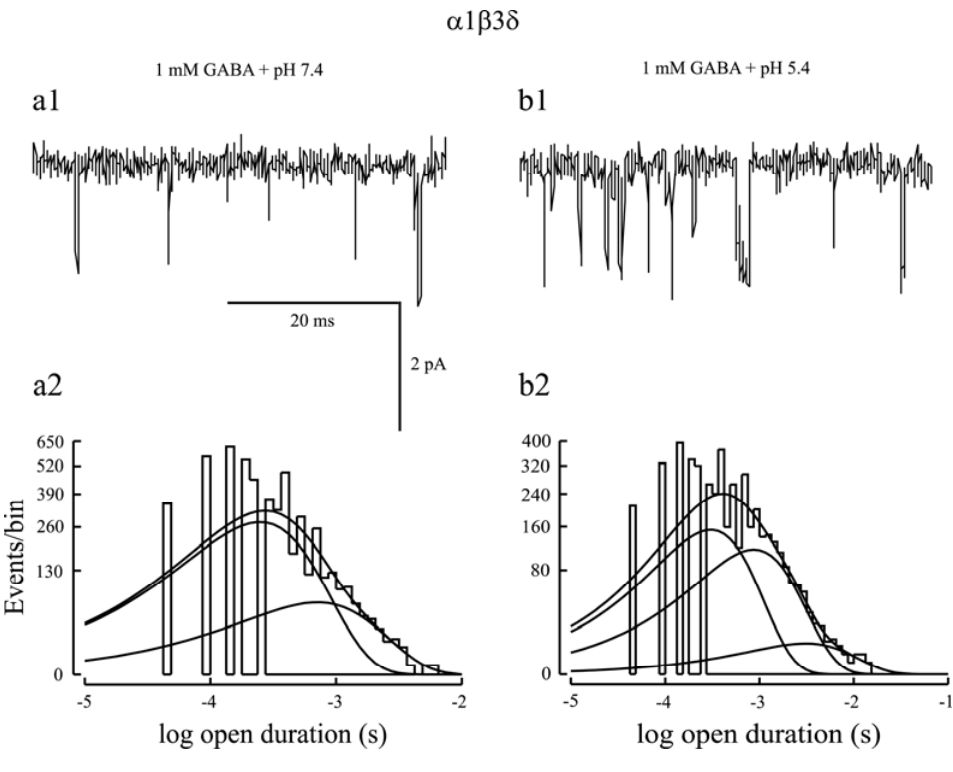
Figure 3. (a1, b1) Representative α 1 β 3 δ receptor single channel current traces evoked by a saturating concentration of GABA at physiological pH (7.4) and acidic pH (5.4) were presented. The single channel activity at pH 7.4 exhibited brief openings, but that at pH 5.4 displayed a mixture of brief- and long-duration openings; (a2, b2) Single channel open probability histograms at physiological pH (7.4) and acidic pH (5.4) were presented. At pH 7.4, the histogram was fitted by two components, indicating two open states. However, at pH 5.4, the histogram was fitted by three components, suggesting that lowered pH introduced an additional open state into α 1 β 3 δ receptors to enhance the efficacy of this receptor isoform. Since protons could not directly activate GABA receptors, the third open state was caused A by allosteric modulation of α 1 β 3 δ receptors by protons. Modified from